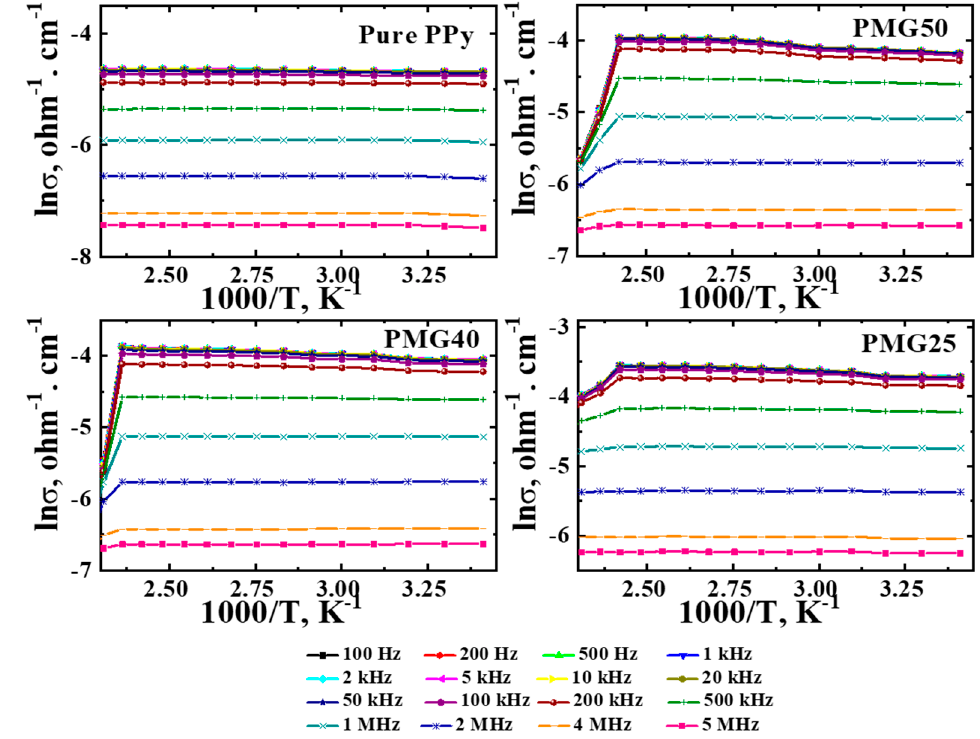
Figure 5. Ac-conductivity versus 1000/ T for pure PPy and PMG composites with different ratios. Comparing the conductivity values measured at 400 K and 100 kHz (Table 1) for pure PPy and PMG composites indicated higher conductivity values for PMG composites than for pure PPy. In addition, the conductivity value was observed to increase with increasing PPy ratio in the composites. The possible persuading reason for this behavior is that including the conducting GO in the PPy matrix would increase the conductivity. PPy conductivity over that of